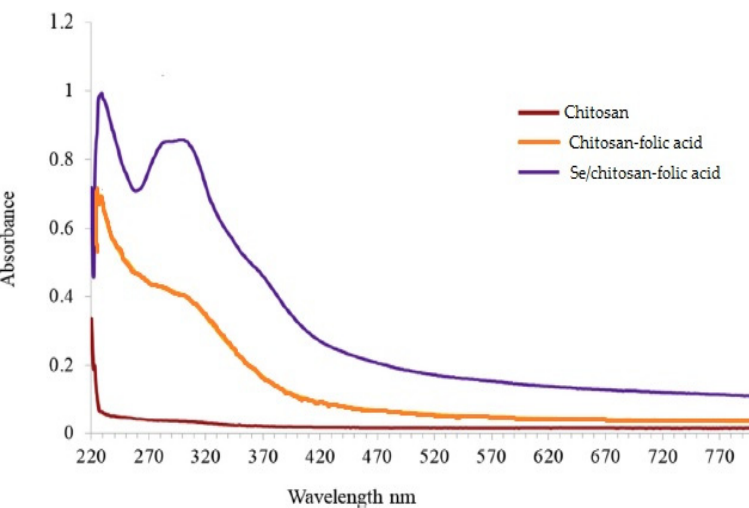
Figure 3. UV–Vis absorbance spectra of chitosan, chitosan-folic acid, and Se/chitosan-folic acid.